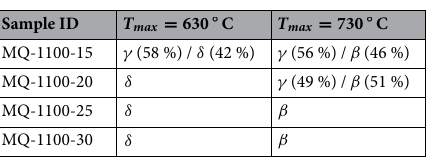
Table 3. Phase composition (in vol percent) of the materials under study after their thermal treatment at T max = 630 and 730 ◦